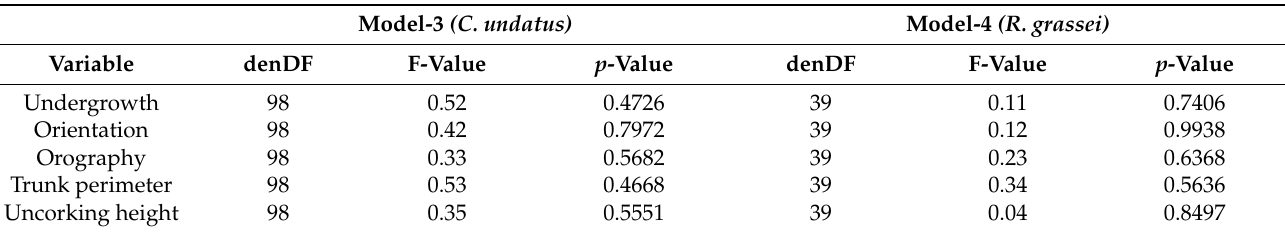
Table 8. Results of the generalized linear models (Model-3 and Model 4) using the Tree Damage Intensity index as response variables; denDF = degree of freedom of the